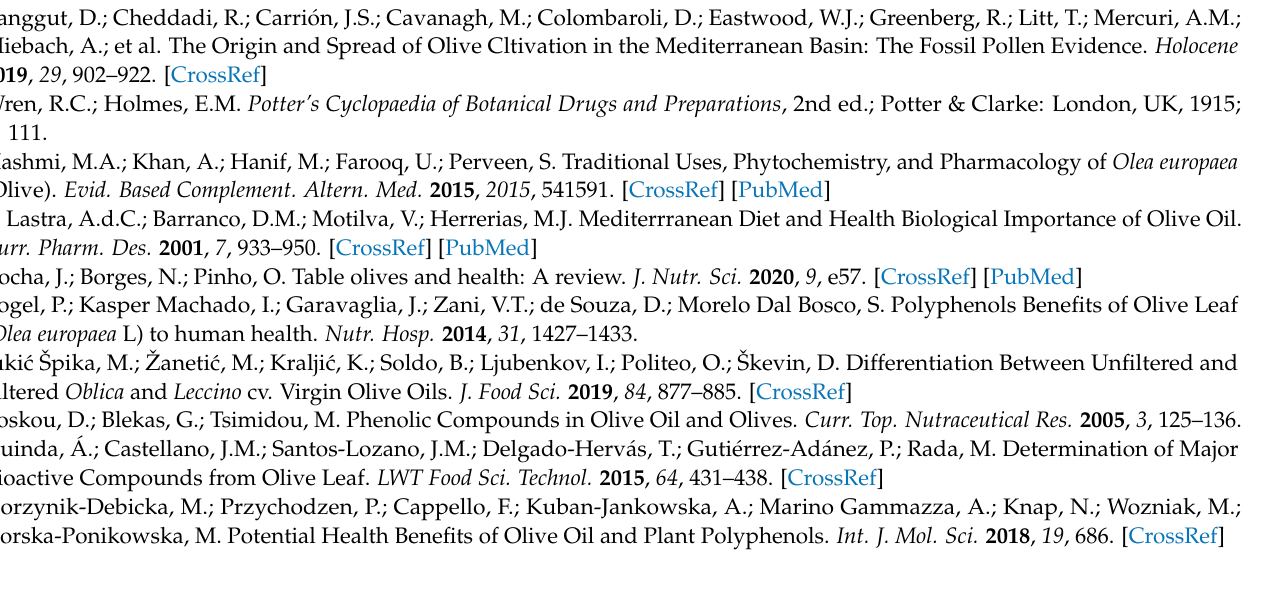
Figure S1: Total ion chromatogram of olive vegetative bud essential oils from (a) cv. Lastovka (b) cv. Oblica ; Figure S2: HPLC chromatograms of olive vegetative bud methanol extracts for (a) cv. Lastovka (b) cv. Oblica, at 220 (black line) and 320 nm (purple line); Figure S3: Percentage of metabolically active human breast adenocarcinoma (MDA-MB-231), human breast metastatic adenocarcinoma (MCF-7), and human ovarian carcinoma (OVCAR-3) cell lines after 24, 48, and 72 h of incubation with different concentrations of olive bud essential oils from cvs. Lastovka and Oblica